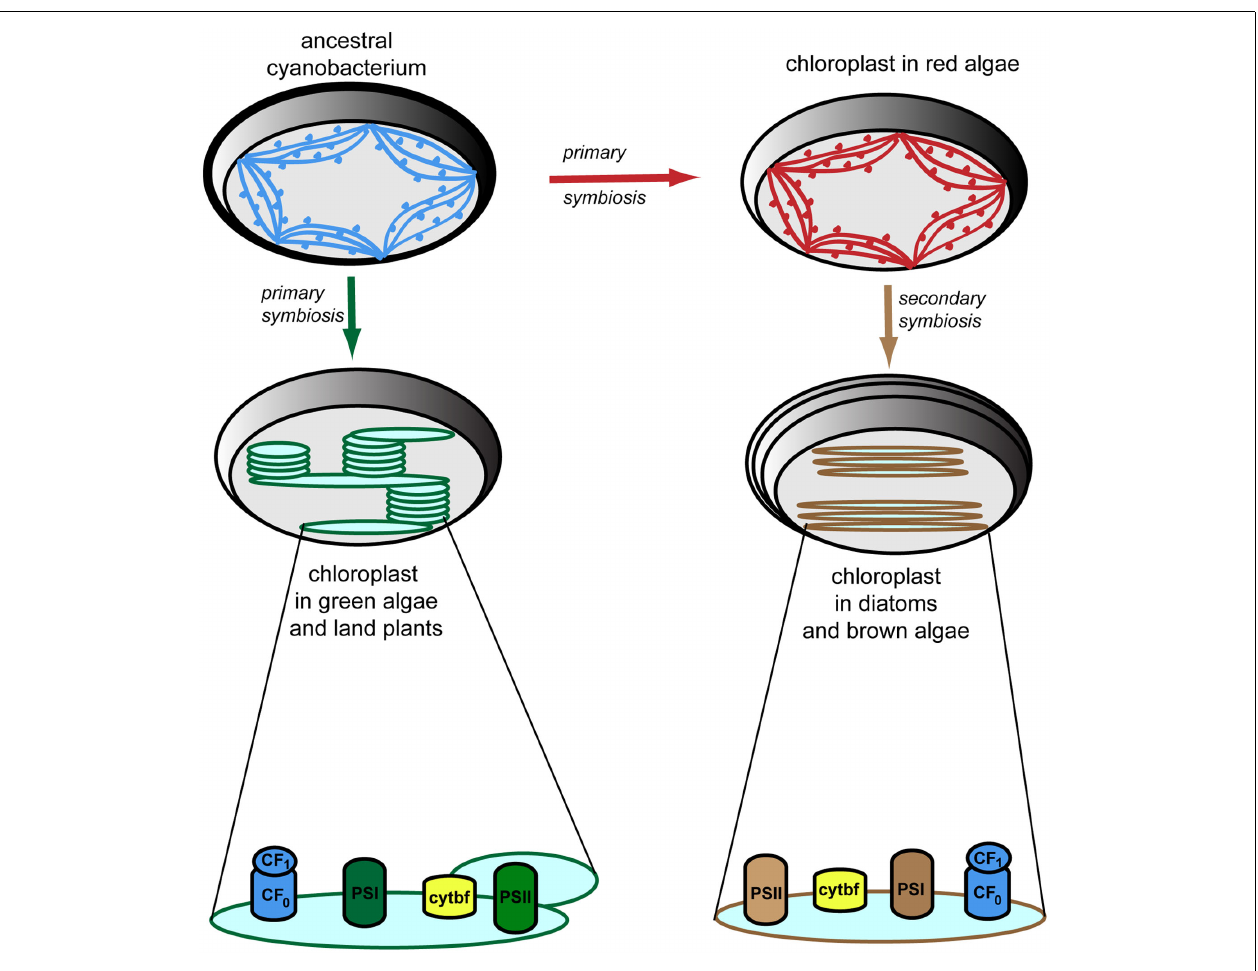
vesicles) interconnected by stroma-exposed lamellae, and contain chlorophyll–protein complexes for harvesting light (Mustardy and Garab, 2003).Various 3D models of the organization of these thylakoid membranes have been proposed and debated (Daum and Kühlbrandt, 2011). According to the most accepted model, based on electron tomography (Daum et al., 2010; Austin and Staehelin, 2011), grana should be seen as stacks of straight, exactly parallel pairs of thylakoid membranes, each pairs of grana disks merging with stroma lamellae by staggered membranes protrusions. Importantly, but not shown in this figure, the plane of the stromal thylakoids is tilted by 10–25˚ relatively to the plane of the grana stack so that the stromal thylakoids display a helix around the granum (Mustardy et al., 2008).The photosynthetic apparatus is composed of four multisubunit complexes, namely the water-oxidizing photosystem II (PSII), cytochrome b 6 /f (cytbf), photosystem I (PSI), and the H + -translocating ATP synthase (CF 0 F 1 ; Nelson and Ben-Shem, 2004).These complexes are laterally distributed in green algae and plants, whereas in other algae and diatoms, they display a more uniform